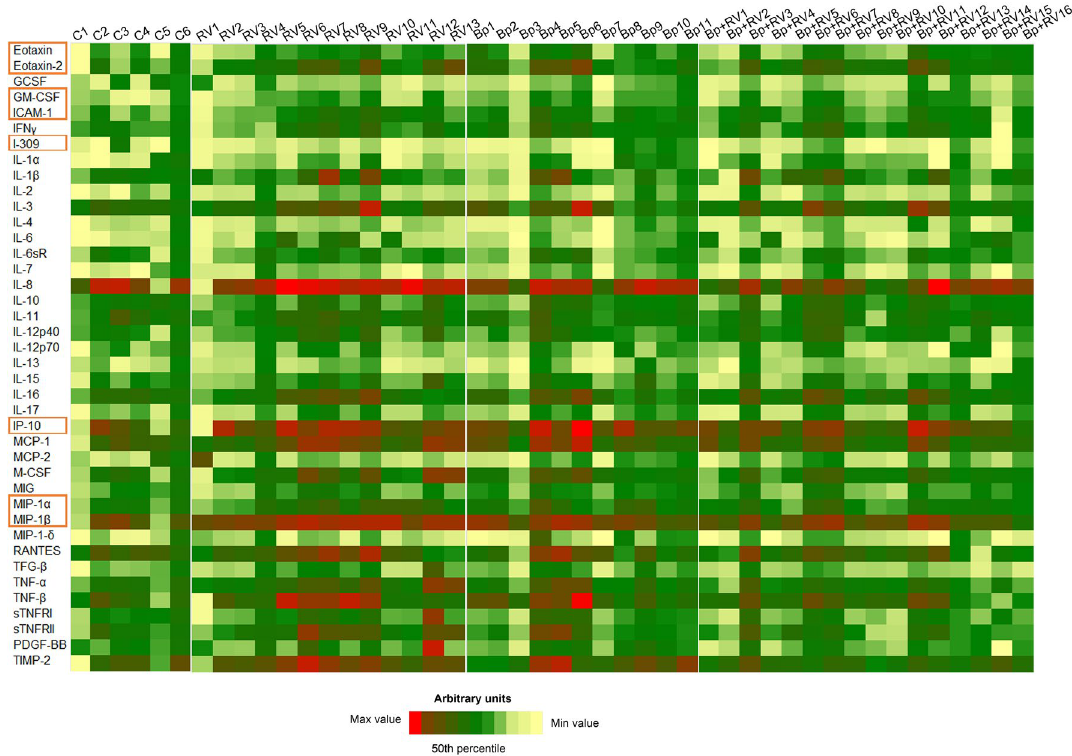
Figure 2. Identification of pattern expression of inflammatory proteins by antibody arrays. Heatmap representation of the mean of semi-quantitative expression of the 40 inflammatory proteins in controls, RV patients, Bp patients , and Bp + RV patients.